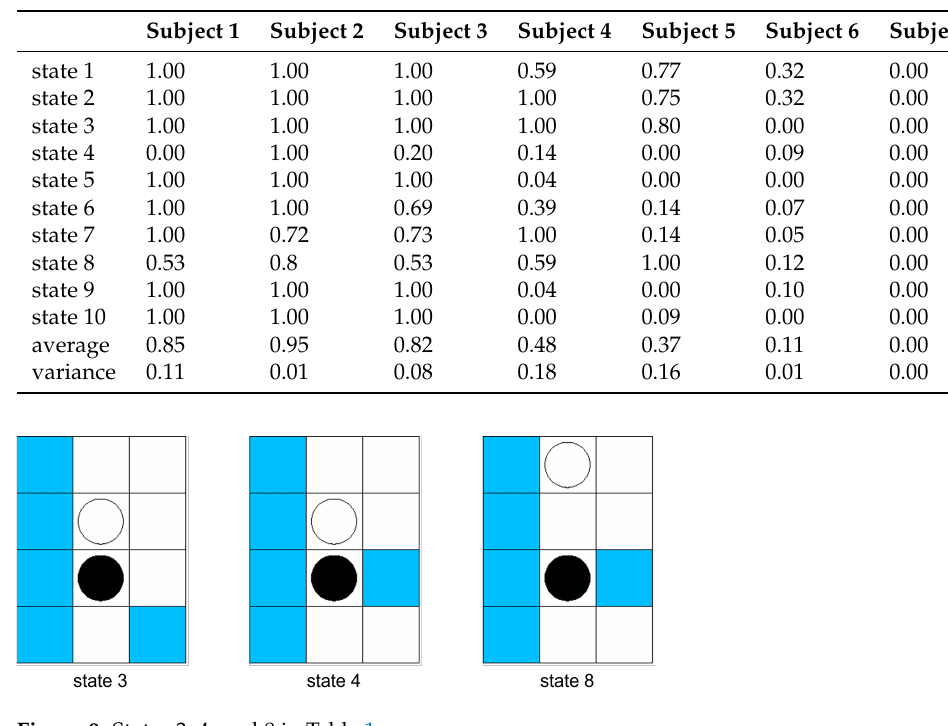
Table 1. Subjects’ scores in the second trial.